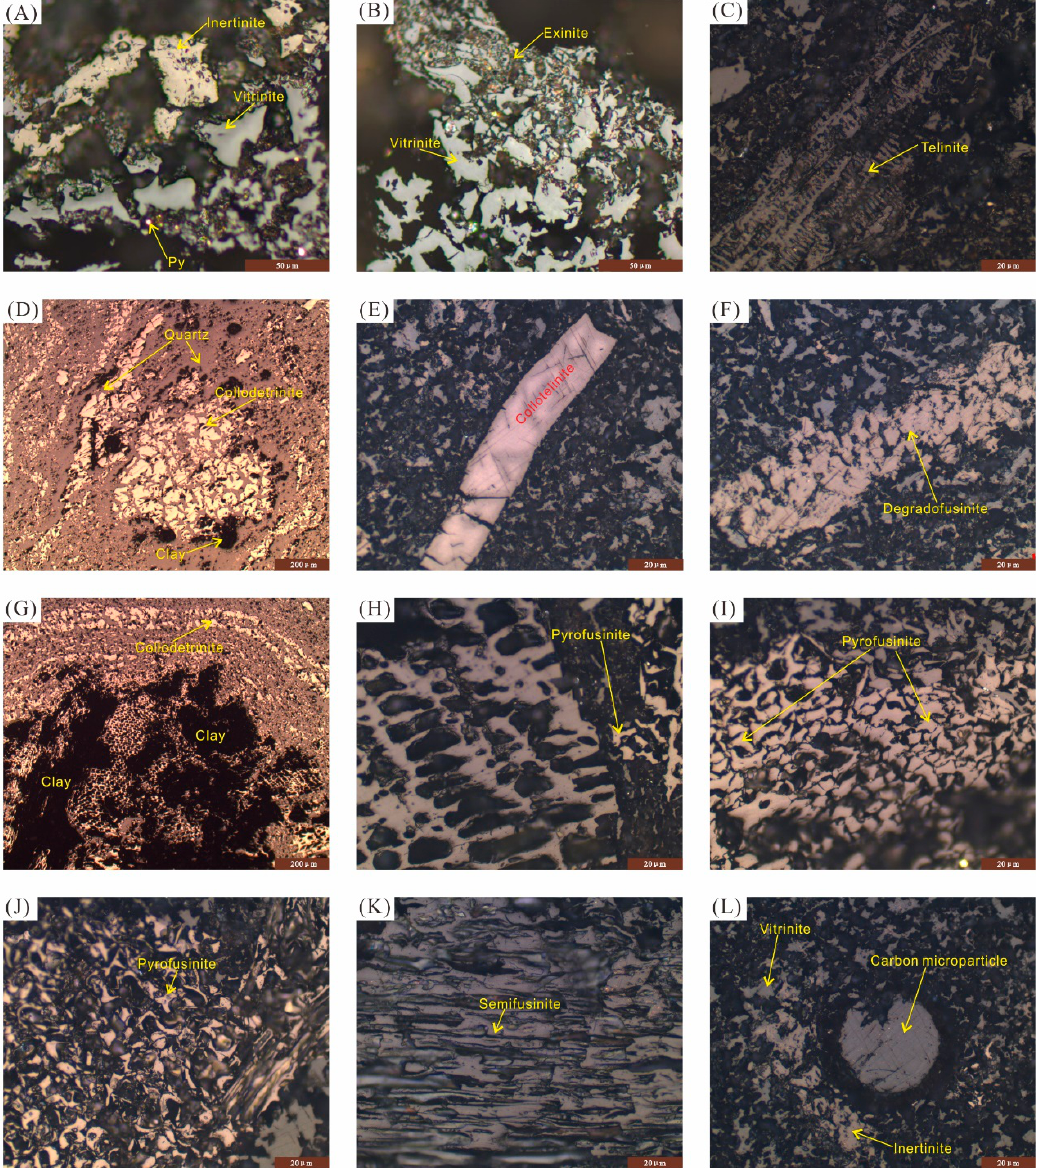
Figure 2. Vitrinite, liptinite and inertinite macerals in the C1 coal. ( A ) Vitrinite and inertinite; ( B ) Vitrinite and liptinite; ( C ) Lepidophytotelinite showing secondary xylem and scalariform pits; ( D ) Oxidized collodetrinite with dessication cracks; ( E ) Oxidized collotelinite with dessication cracks; ( F ) Degradofusinite showing the transition from vitrinite to inertinite; ( G ) Inertinite showing well-preserved cell structure; ( H ) Magnification of ( G ), lepidophytofusinite (peridem) and pyrofusinite; ( I ) Magnification of ( G ), pyrofusinite showing ‘bogen’ structure; ( J ) Magnification of ( G ), pyrofusinite showing ‘bogen’ structure; ( K ) Semifusinite with well-preserved cell structure; ( L ) Ellipsoidal carbon microparticle displaying homogeneneous structure, showing the transition from vitrinite to inertinite. All photomicrographs were taken under reflected light, ( A , B ) maceral plate; ( C – L ) polished blocks; ( A , B , D , G ) dry objective; ( C , E , F , H – L ) oil